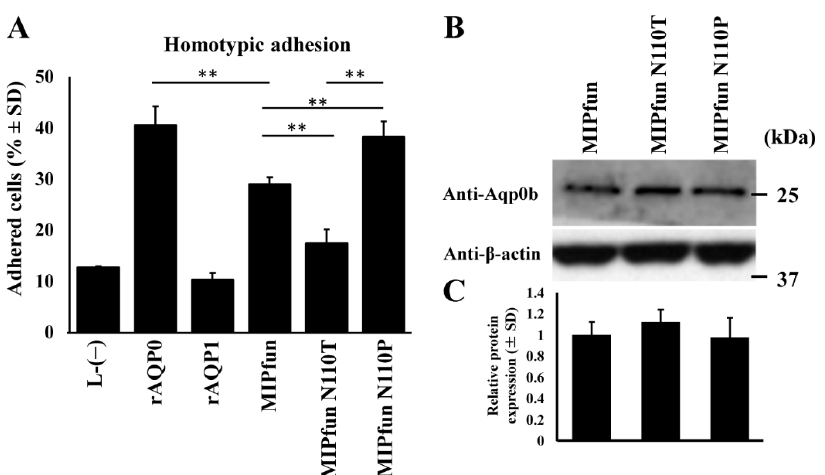
Figure 4. MIPfun’s adhesive properties are enhanced by an N110P mutation. ( A ) Adhesive properties were tested between homotypic pairs of stable cell lines expressing WT MIPfun and mutated variants. Each lane represents n = 6–8. ( B ) Western blot analysis example shows equal expression of the protein between WT and mutant variants using the rabbit anti-zebrafish Aqp0b sera quantified in ( C ) ( n ≥ 3). Statistical differences are shown as ** having p < 0.01.